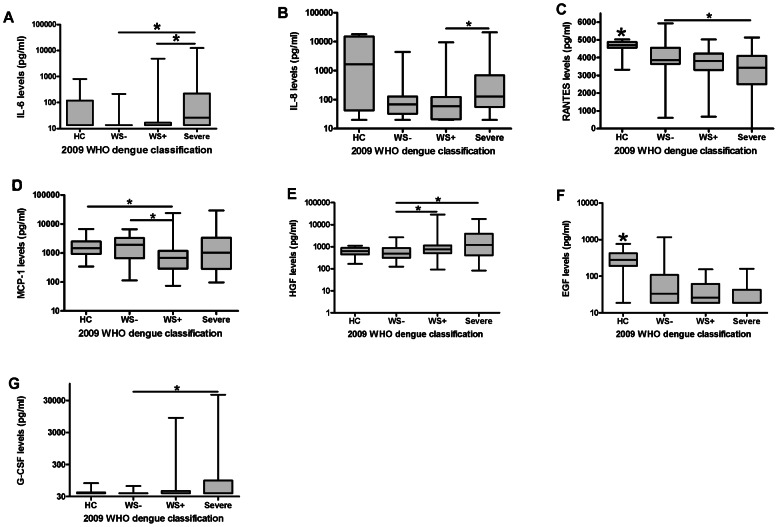
Cytokine levels in dengue virus infected patients classified according to the 2009 WHO dengue classification.A: IL-6: Levels in severe patients are significantly increased compared WS− (P<0,0001) and WS+ (P<0,0001) patients (KW P<0,0001, KW dengue groups P<0,0001). B: IL-8: Levels in severe patients are significantly elevated compared to WS+ patients (P = 0,004) (KW P = 0,004, KW dengue groups P = 0,011). C: RANTES: Levels in severe (P = 0,002) patients are significantly decreased compared to WS− patients. Levels in all patient groups are significantly decreased compared to HC (WS− vs HC P = 0,001, WS+ and severe vs HC P<0,0001), (KW P<0,0001, KW dengue groups P = 0,006). D: MCP-1: Levels in WS+ patients are significantly decreased compared to WS− (P = 0,001) patients and HC (P = 0,008) (KW P = 0,006, KW dengue groups P = 0,006). E: HGF: Levels in severe (P = 0,001) and WS+ (P = 0,005) patients are significantly increased compared to WS-patients (KW P = 0,001, KW dengue groups P = 0,001). F: EGF: Levels in all patient groups are significantly decreased compared to HC (WS−, WS+ and severe vs HC P<0,0001, KW P<0,0001, KW dengue groups P = 0,03). G: G-CSF: Levels in severe patients are significantly increased compared to WS- patients (P = 0,003, KW P = 0,02, KW dengue groups P = 0,008). Legend: HC = healthy control, WS− = non-severe dengue without warning signs. WS+ = non-severe dengue with warning signs, KW = kruskal wallis. Horizontal bars inside the boxplot indicate the median. The box indicates the interquartile range. Black asterisk = significantly different from all other groups. Underlined black asterisk = significant difference between two groups. The Mann-Whitney U test was used to compare the groups with each other.